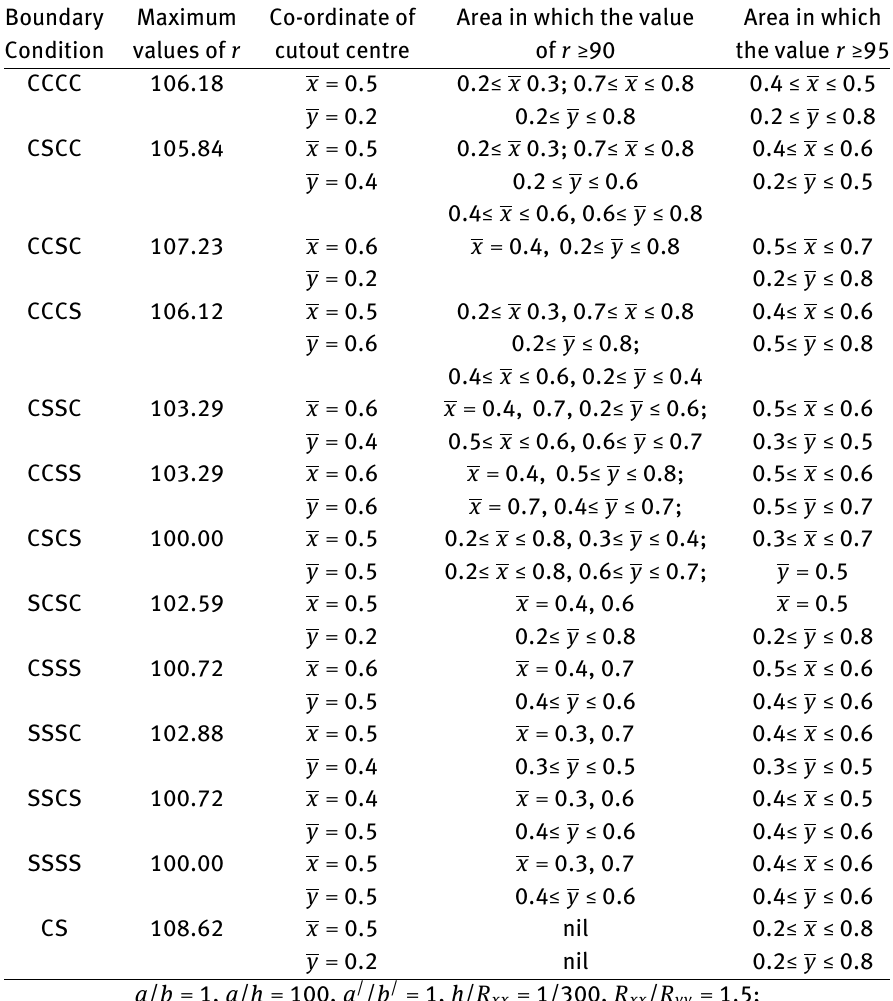
Table 9: Maximum values of r with corresponding coordinates of cutout centres and zones where r ≥ 90 and r ≥ 95 for 0/90/0/90 elliptic parabolic